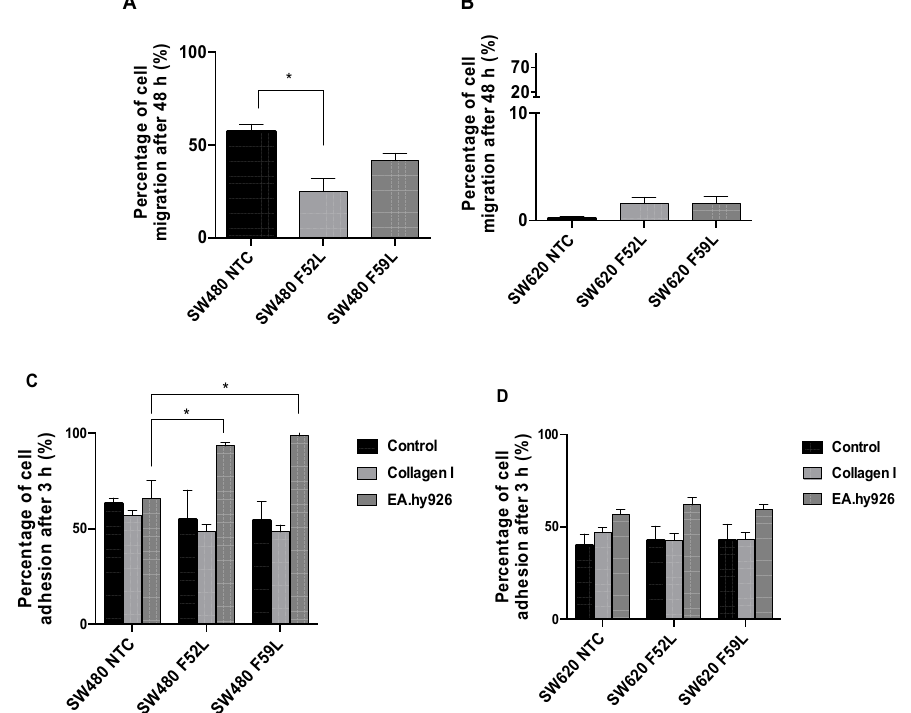
Figure 5. Migration and adhesion capacity of SW480 and SW620 FUT8 knockdown cells. ( A , B ): Transwell Boyden chamber assays interrogated the cellular migration of FUT8 -silenced F52 and F59 clones compared to respective non-targeted controls. The cells were loaded in the upper side of the Boyden chambers, and incubated for 48 h. Migratory cells passing through the membrane were collected after trypsin detaching, and stained with calcein, and their fluorescence intensity was measured. The experiments were performed three times. The cells were seeded in triplicate, and the results were plotted as percentages of the migrated cells relative to the seeded cells. ( C , D ): Adhesion of the SW480 and SW620 NTC cells and the FUT8 -silenced counterparts was tested using conventional culture plates, collagen type I-coated plates, and plates with a monolayer of EA.hy926 cells mimicking an endothelial barrier. Adhesive capacity was measured 3 h after seeding. The results were plotted as percentages of the adhered cells relative to the initial seeding number. Plots represent mean ± SEM of quadruplicate wells from three experiments. NTC clones were used as reference for statistical calculations. An unpaired t -test was applied for statistical analysis; * p <